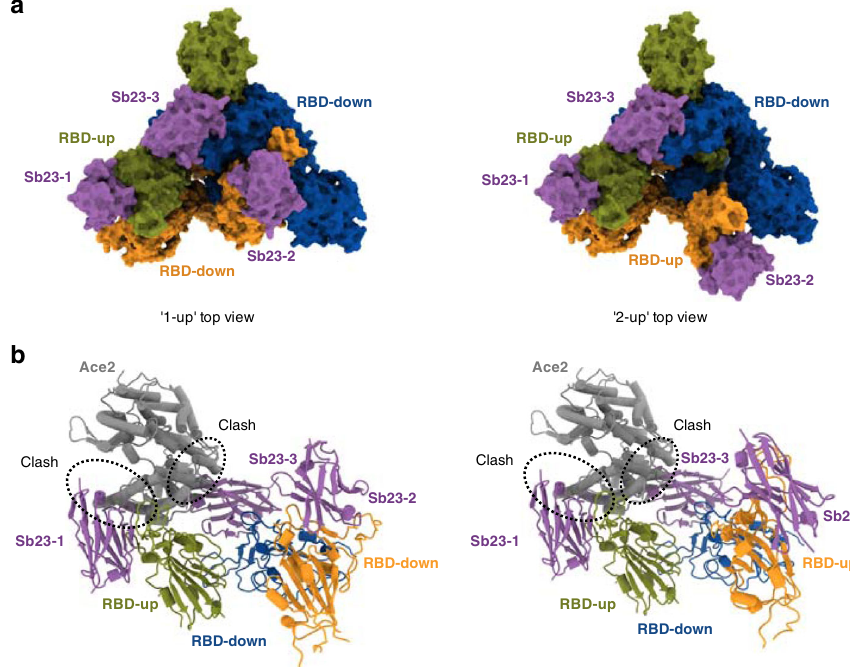
Fig. 6 Top view of cryo-EM reconstruction of SARS-CoV-2 spike bound to Sb23 and modeling of the structural basis for Sb23-based blockage of SARS- CoV-2 spike binding to ACE2. a Top view of locally sharpened Coulomb potential map and cartoon model of Sb23 bound to the spike protein in the “ 1-up ” conformation b Top view of locally sharpened Coulomb potential map and cartoon model of Sb23 bound to the spike protein in the “ 2-up ” conformation. c Cartoon model of Sb23-bound Spike in the “ 1-up ” (left) “ 2-up ” (right) conformation showing how ACE2 binding is blocked by Sb23 bound to the RBD in the “ up ” conformation as well as Sb23 bound to the neighboring RBD in the down